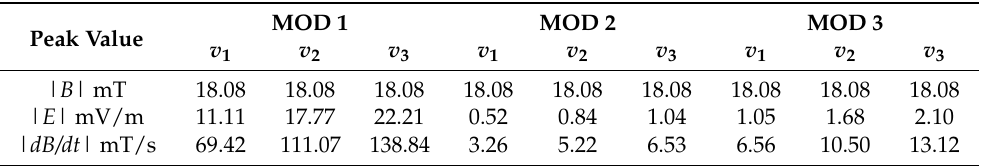
Table 3. Peak values of the calculated exposure parameters for z = 80 cm (hip in standing position or head in squatting